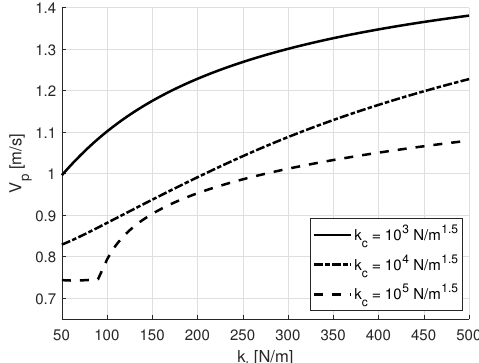
Figure 16. Effects of the stiffness and of the damping of the decoupling system on the final velocity of the object with e =